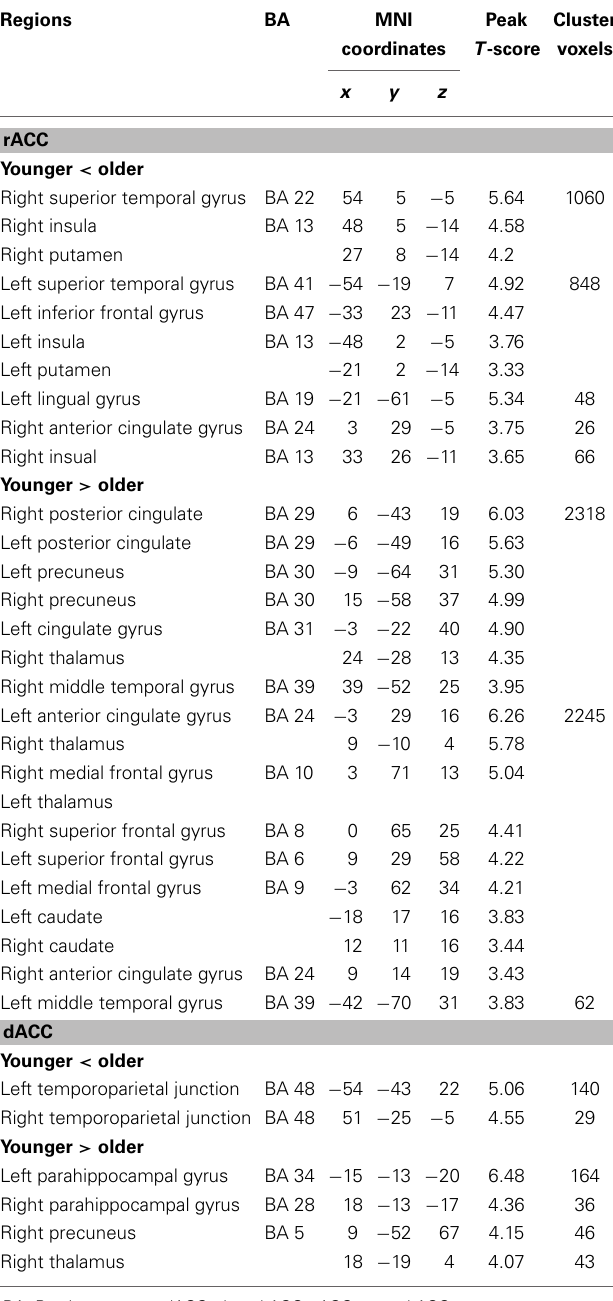
Table 1 | Significant differences for resting-state functional connectivity of the rACC and dACC in older adults compared with younger